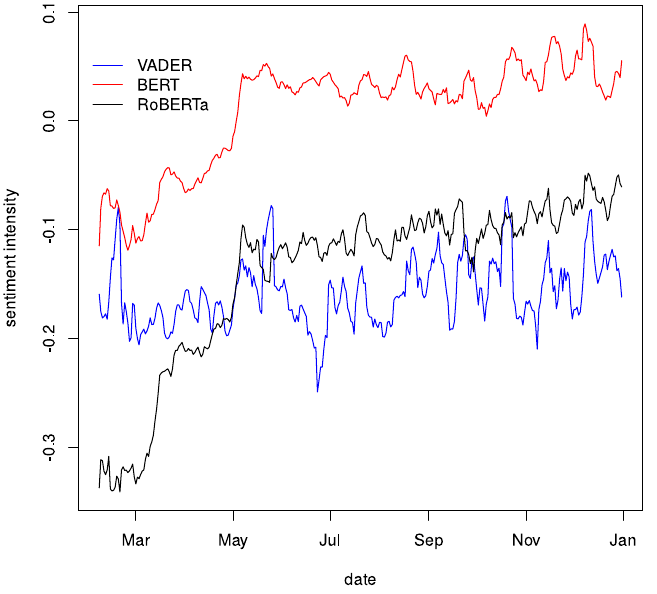
Figure A5. Year–Long time series of daily averaged compound sentiment polarity of COVID-19-related tweets in Mexico . Each line represents a time series based on the same dataset collected [6] and restricted to Mexico, from 2 February to 31 December 2020. Data were smoothed via a 7-day rolling